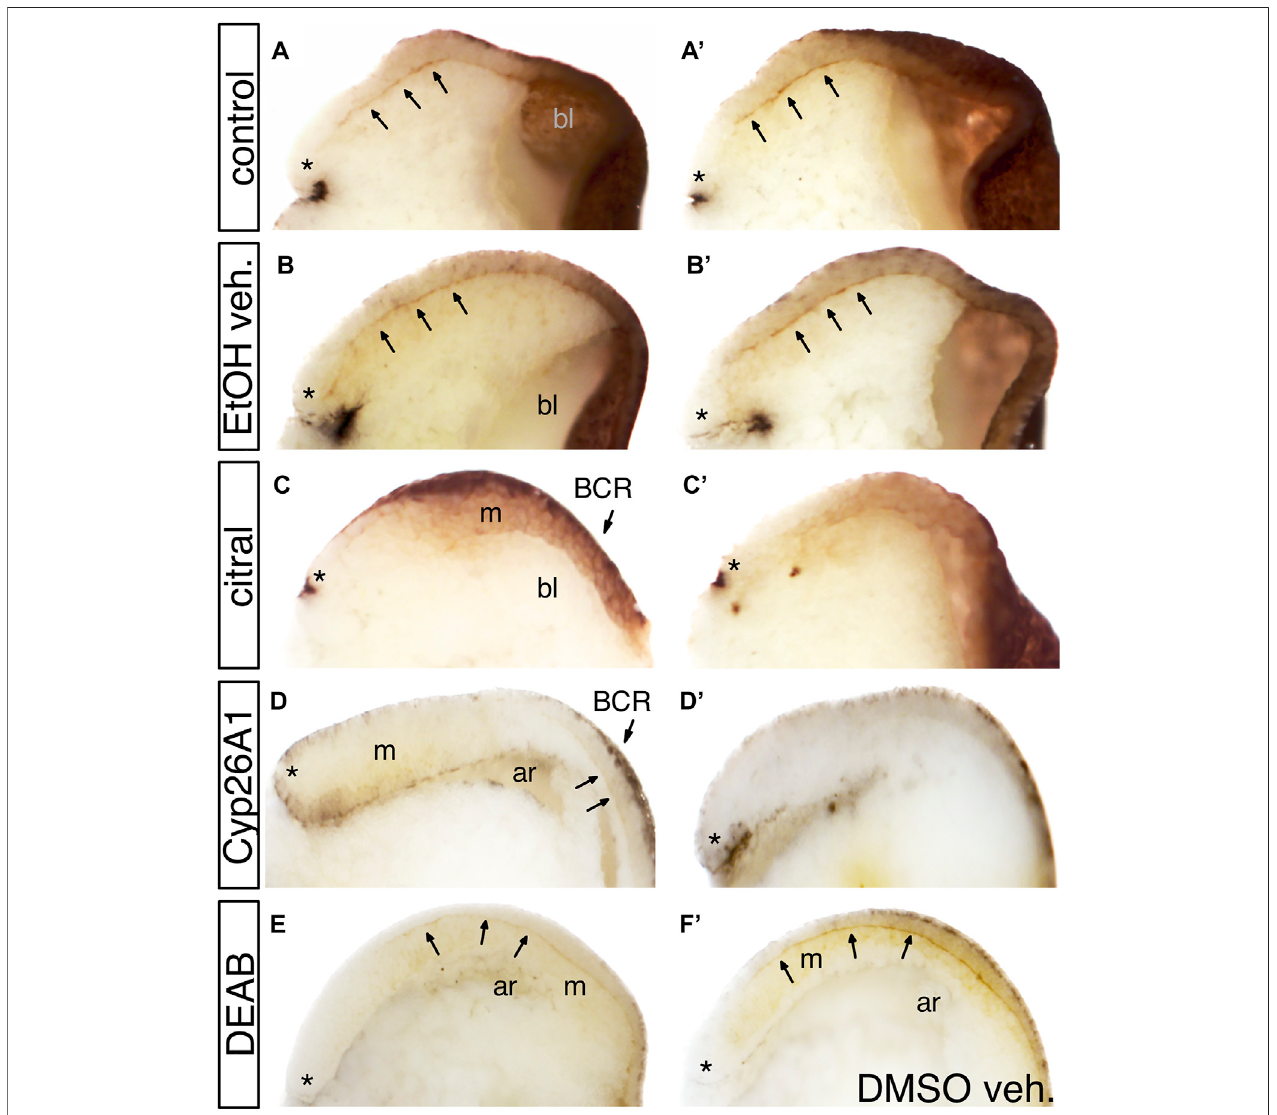
FIGURE3| TheeffectofreducedRAsignalingon fi bronectin(FN)deposition.EmbryosweretreatedwithDEABorcitralorinjectedwithRNAencodingCYP26A1to reduce RA levels. (A,A 9 ) Two examples of untreated sibling control embryos. Arrows point to fi bronectin deposited along Brachet ’ s cleft. * indicates the dorsal lip of the blastopore;bl,blastocoel. (B,B 9 ) TwoexamplesofembryostreatedwithEtOHvehicleonly.FNdepositionwasequivalenttountreated controls. (C,C 9 ) Twoexamplesof embryos treated with citral. FN is detected in the ectoderm of the blastocoel roof (BCR) and mesoderm (m), but is not deposited along Brachet ’ s cleft. (D,D 9 ) Two examples of embryos injected with cyp26a1 mRNA. FN is not detected in the BCR, the mesoderm (m), or Brachet ’ s cleft (arrows). ar, archenteron. (E) Embryo treated with DEAB showed reduced FN staining along Brachet ’ s cleft compared to a sibling embryo treated only with DMSO vehicle (F) .